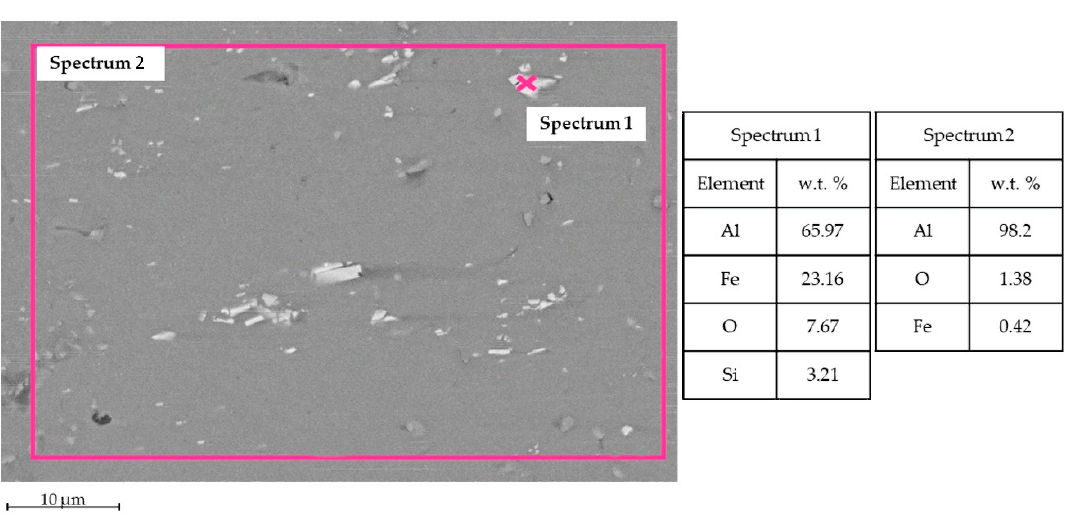
Figure 9. MIG welding analysis. Left side: SEM image and EDS in WZ. Right side: SEM image and